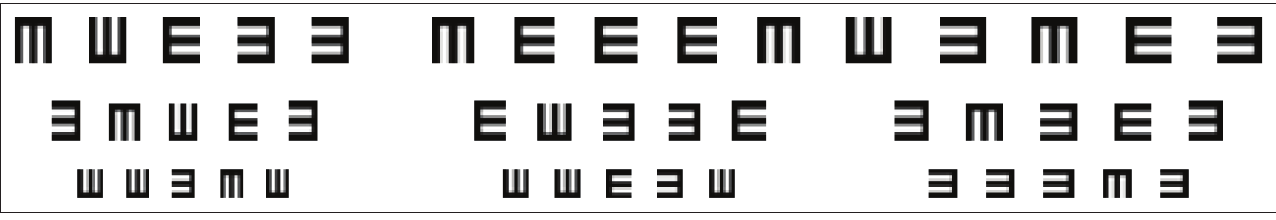
FIGURE 1: Simplified logMAR chart which author designed and used for screening. Design principle is based on logMAR.